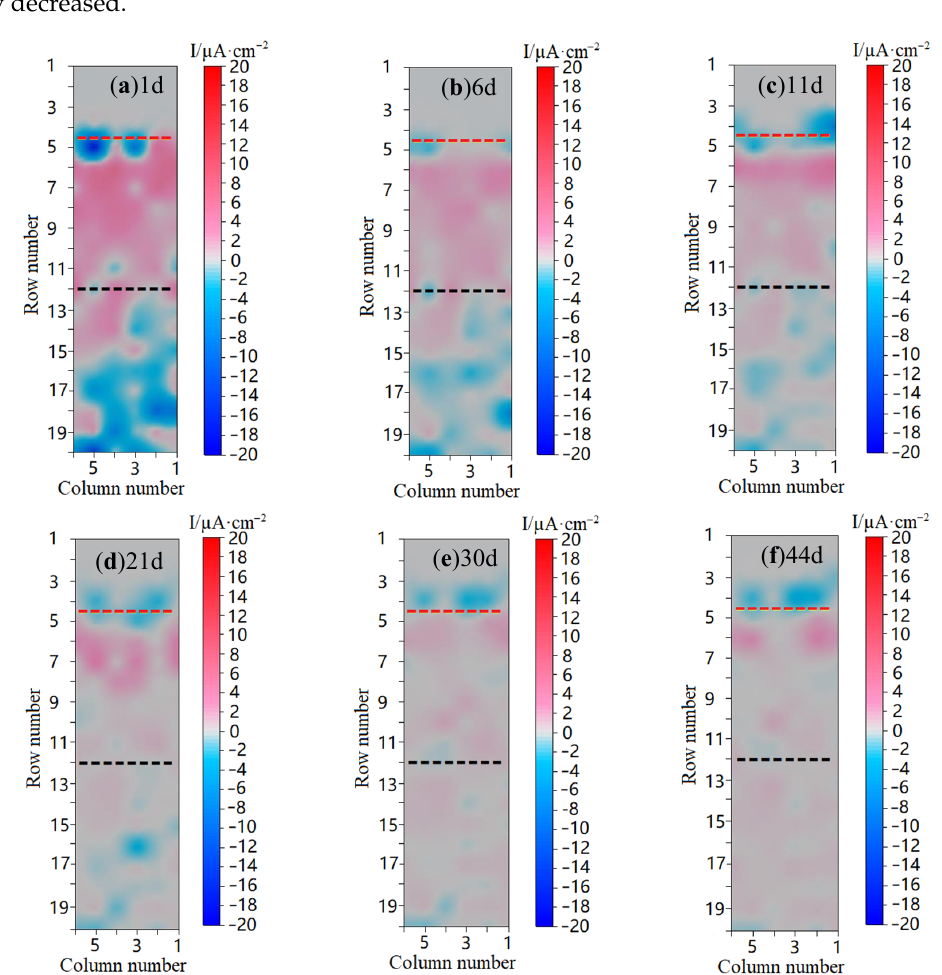
Figure 2. Galvanic current recorded on the Wire Beam Electrode (WBE) in sea mud/seawater/atmosphere environment for various immersion days. ( a – f ) correspond to 1, 6, 11, 21, 30, and 44 days, respectively.